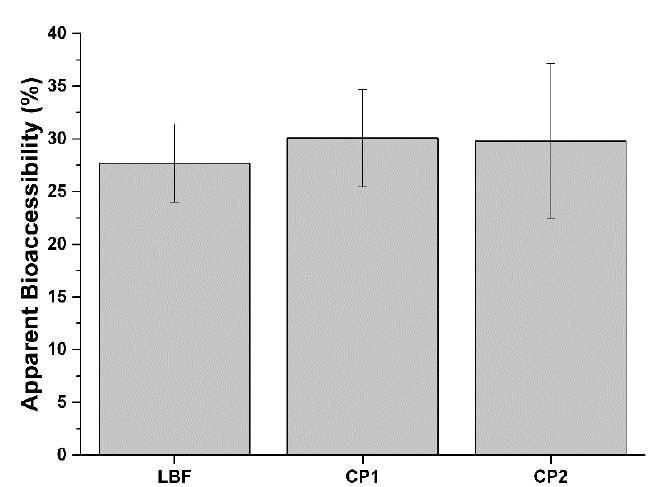
Figure 8. Apparent bioaccessibility of SRO contained in LBF and the two commercial formulations, CF1 and CF2. ( n = 3).